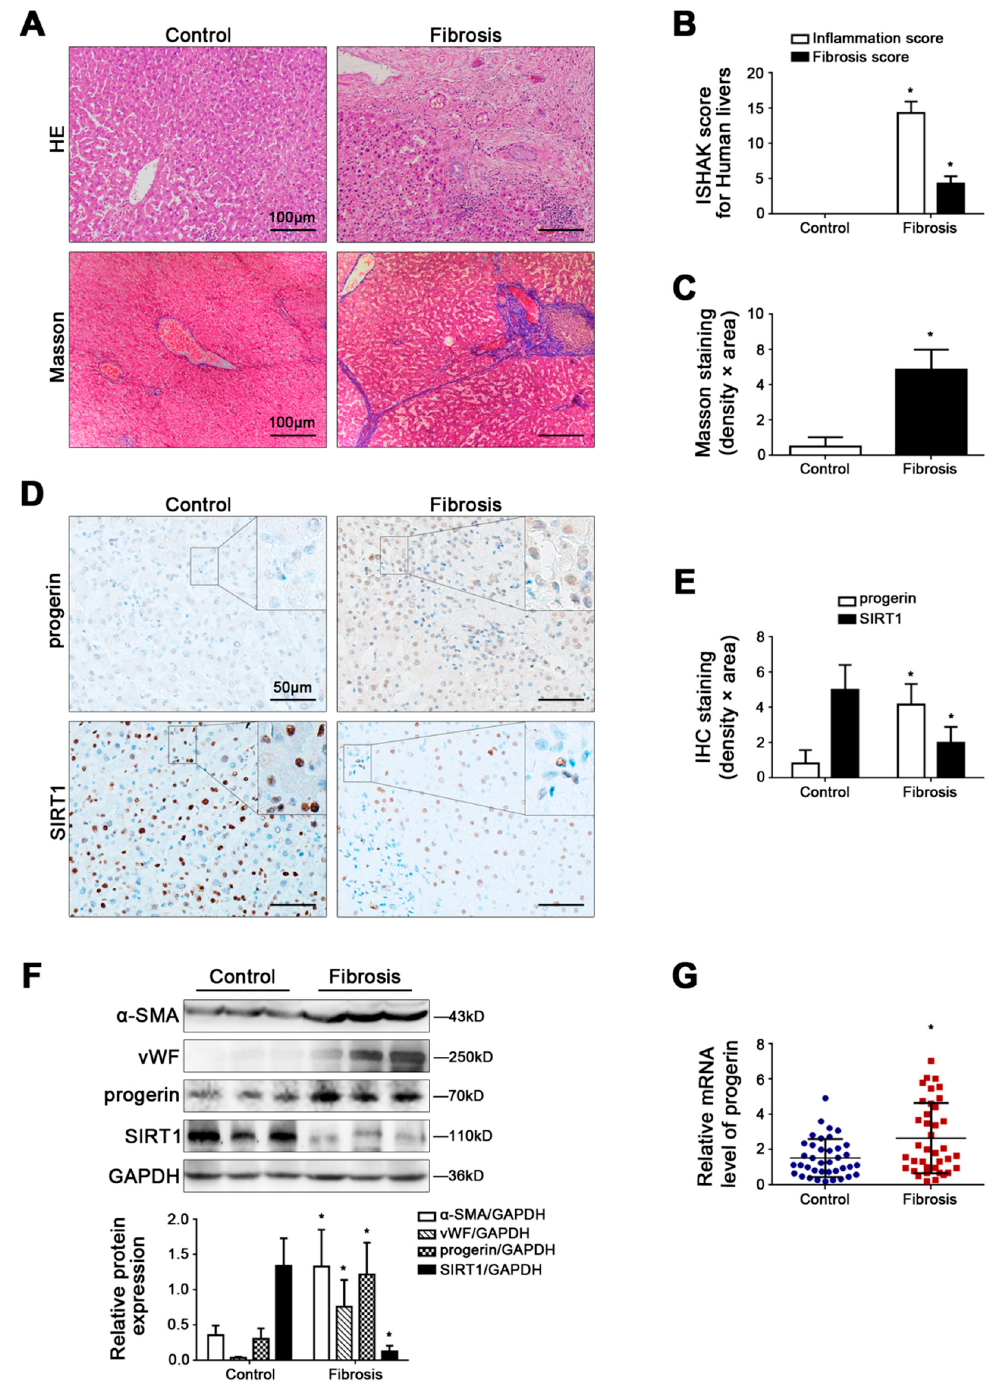
Figure 1. Progerin is elevated in human liver fibrosis, along with depletion of SIRT1. ( A ) HE and Masson staining in human liver specimens (Scale bar: 100 μ m). ( B ) The quantified analysis of liver inflammation and fibrosis with ISHAK score in the graph. * p < 0.05 versus the control group. ( C ) The semi-quantified analysis for the area density of Masson staining in the graph. * p < 0.05 versus the control group. ( D ) IHC staining for progerin and SIRT1 in human liver specimens (scale bar: 50 μ m). ( E ) The semi − quanti fi ed analysis for the area density of IHC staining of progerin and SIRT1 in the graph. * p < 0.05 versus the control group. ( F ) Representative immunoblots of α− SMA, vWF, progerin, and SIRT1 in human liver tissue. The relative protein levels were quantified in the graph (below). * p < 0.05 versus the control group. ( G ) RT − qPCR analysis for progerin mRNA level in human peripheral blood granulocytes. * p < 0.05 versus the control group.